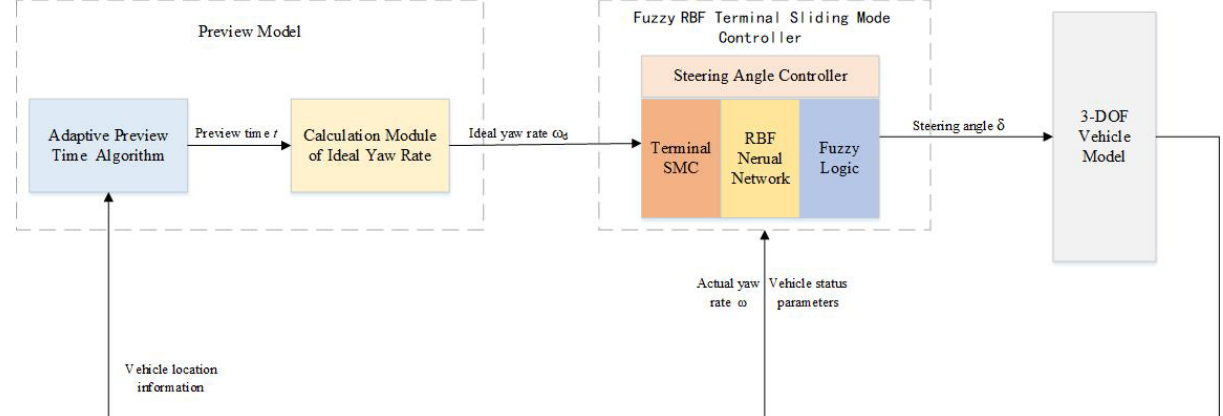
Figure 3. Controller structure in this